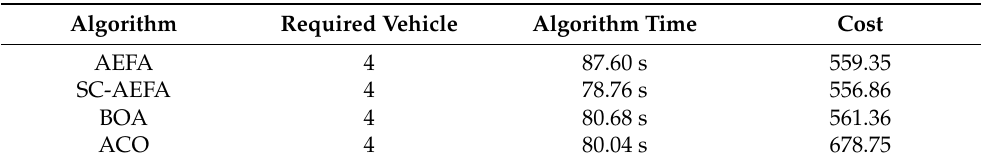
Table 6. The comparison of the results.